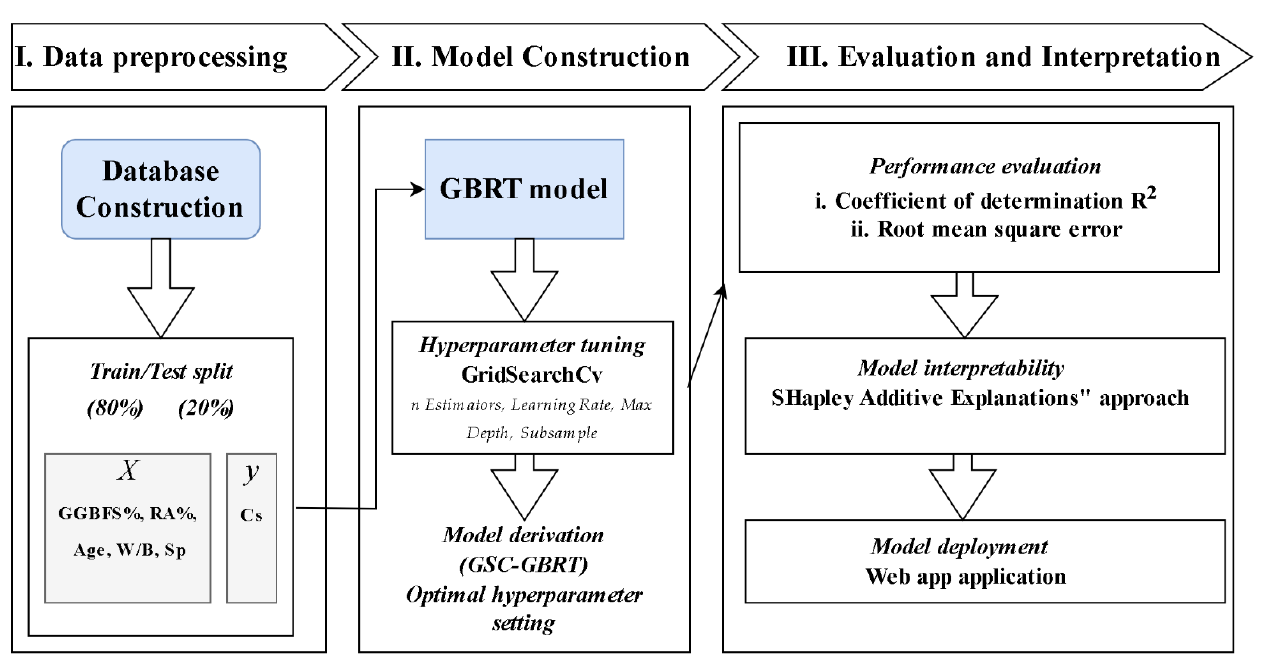
Figure 1. Research methodology.